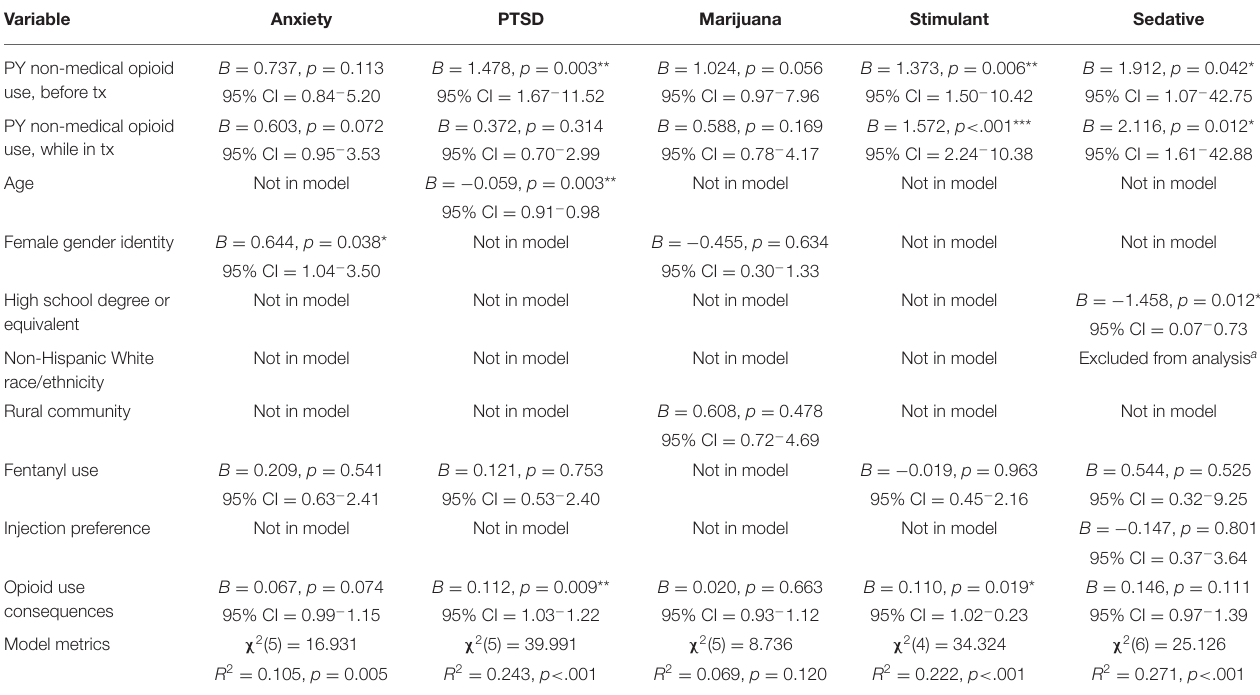
TABLE 4 | Multivariable regressions of comorbid disorders.